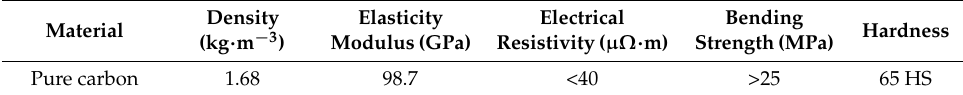
Table 1. Physical properties of the pure carbon strip.